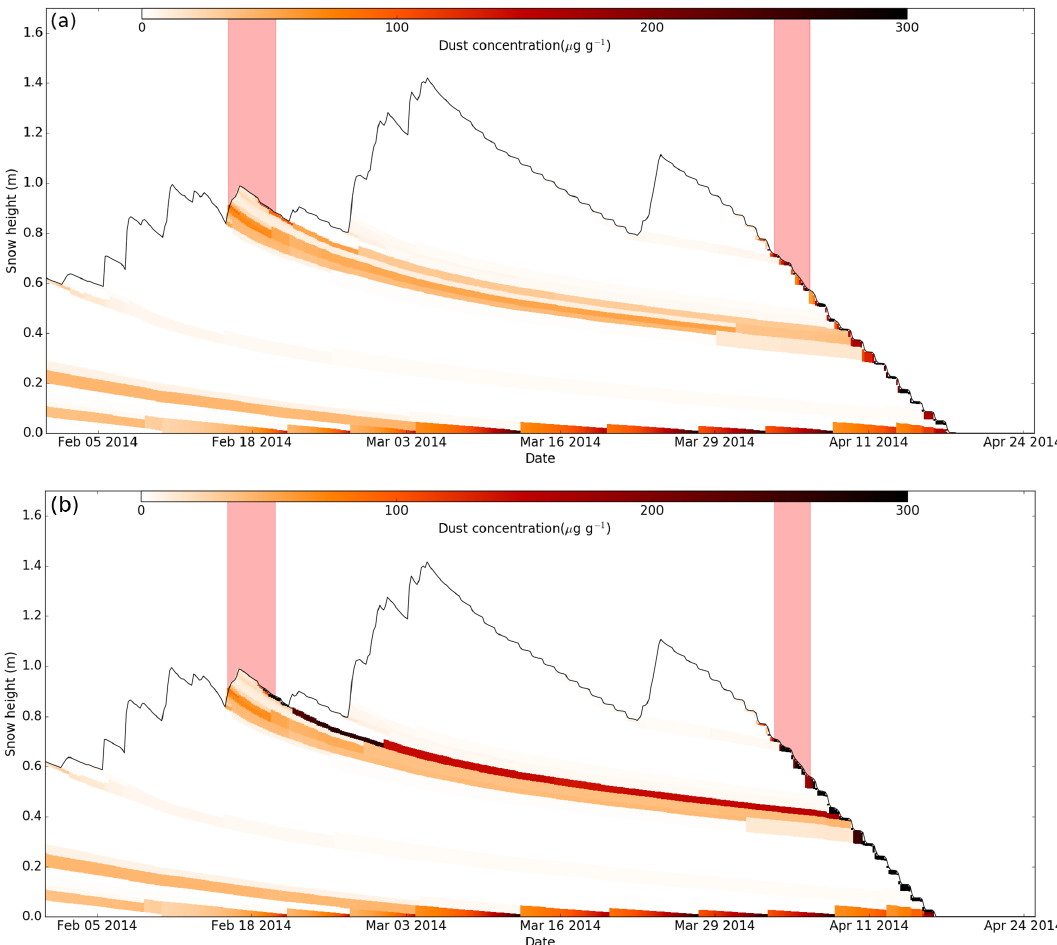
Figure 8. Simulated dust concentration profile for the second half of the 2013–2014 snow season at the Col de Porte. Panel (a) shows the configuration C2 using ALADIN-Climate deposition fluxes. Panel (b) shows the C5 configuration using the same parameters but ALADIN- Climate deposition fluxes have been modified to reproduce the measurements by Di Mauro et al. (2015). The two major Saharan dust events are represented by the red